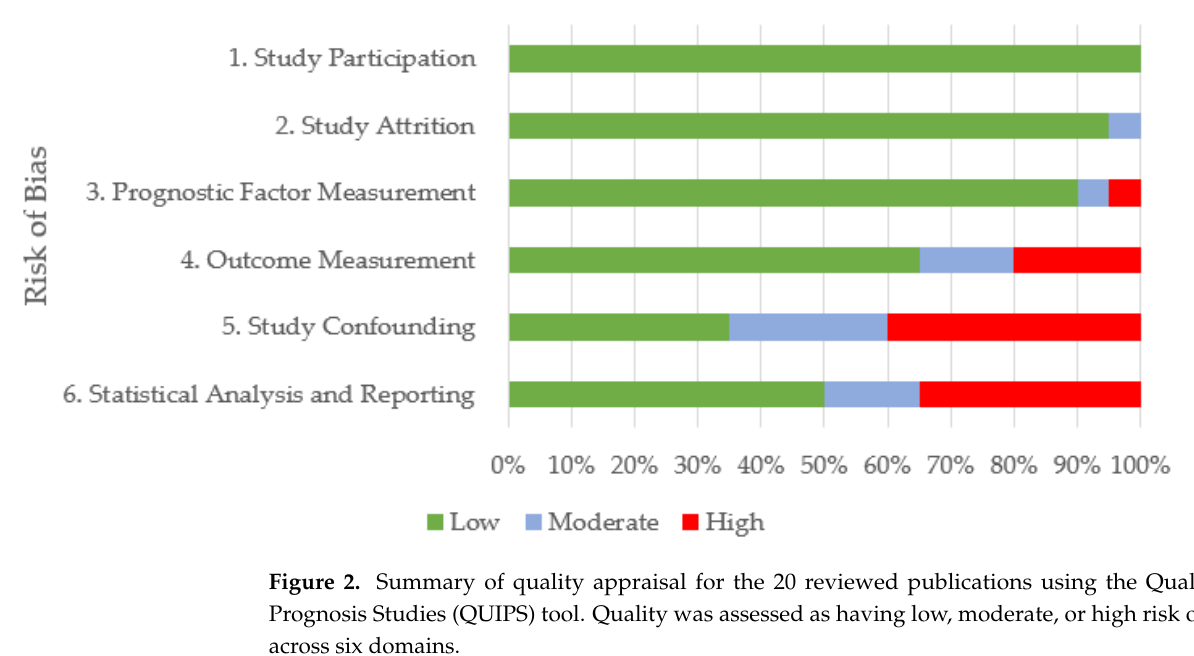
Figure 1. Search and selection flowchart for scoping review of non-structural airway disease as a cause of poor performance in racehorses [17] .